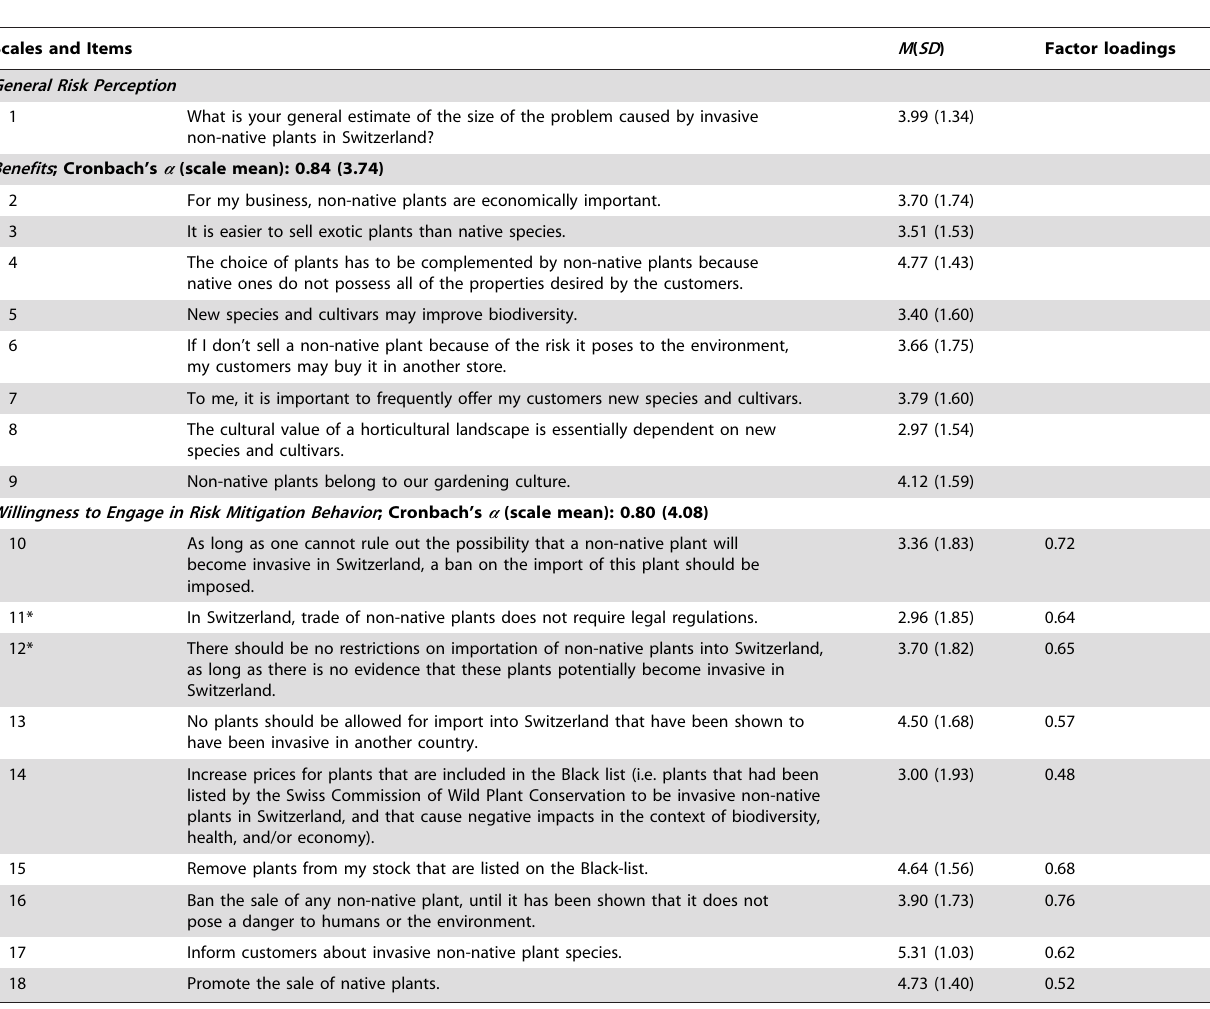
Table 2. Perceptions of risk and benefit, and attitudes towards the willingness to engage in risk mitigation behavior and factor loadings from principal component